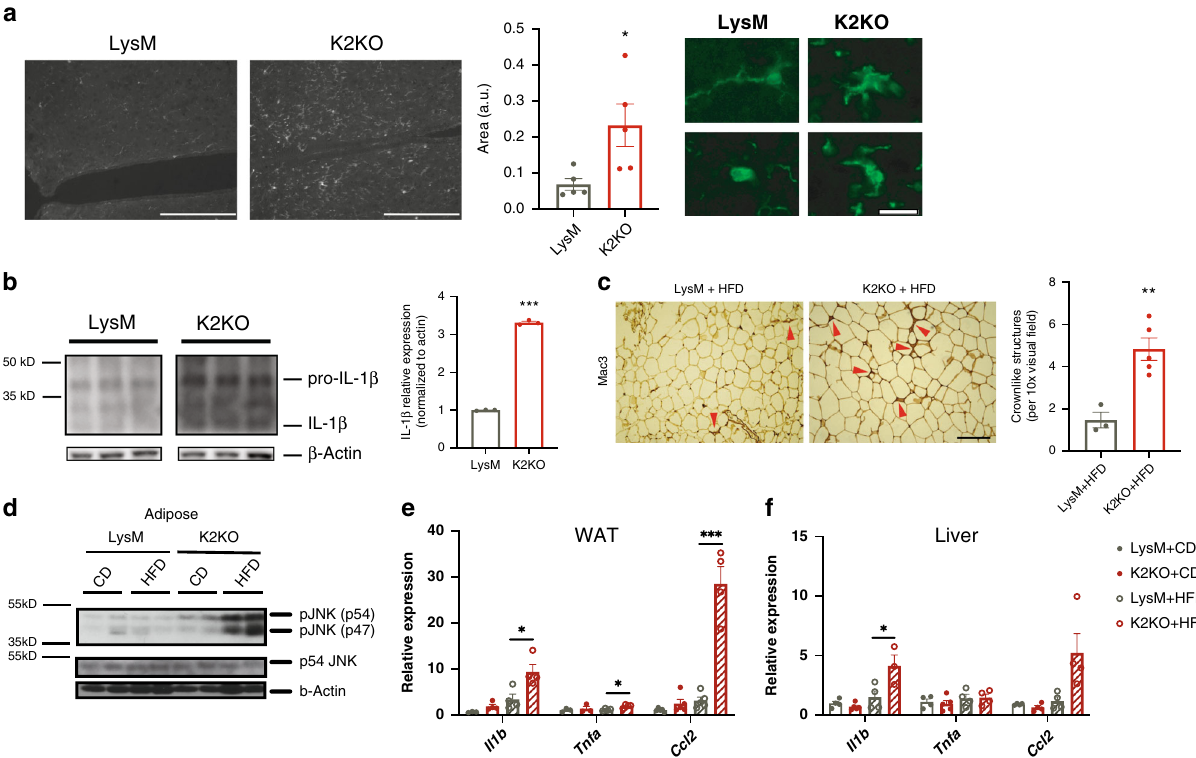
Fig. 3 KLF2 regulates central and peripheral meta fl ammation to resist metabolic disease. a K2KO mice on CD have increased microglial activation within the hypothalamus as exhibited by Iba1 proportional area and characteristic morphological changes, representative images shown, n = 5, p = 0.0277, scale bars: low magni fi cation = 200 µ m, high magni fi cation = 20 µ m. b Western blot on hypothalamic lysates from CD-fed mice demonstrate increased interleukin-1 beta (IL-1 β ) production in K2KO mice, n = 3, p < 0.0001. c Mac3 staining of adipose tissue from HFD-fed mice reveals K2KO mice have macrophage expansion as indicated by increased crownlike structures, representative image, LysM n = 3, K2KO n = 5, p = 0.0045, scale bar = 100 µ m. d Western blot of JNK activity demonstrating that month HFD-fed K2KO mice have elevated JNK phosphorylation, representative blot of n = 2. e In fl ammatory gene qPCR from WAT lysate from CD and HFD-fed mice, n = 4, p values: HFD Il1b = 0.029, HFD Tnfa = 0.0126, HFD Ccl2 = 0.0001. f In fl ammatory gene qPCR from liver lysate from CD and HFD-fed mice, n = 4, HFD Il1b p = 0.0446 by unpaired, two-tailed Student ’ s t -test, comparisons marked or indicated in fi gure legend. Error bars represent SEM. All mice on were fed CD/HFD for 1 month unless otherwise indicated. n represents biologically independent mice throughout entire fi gure. Source data are provided as a Source Data fi